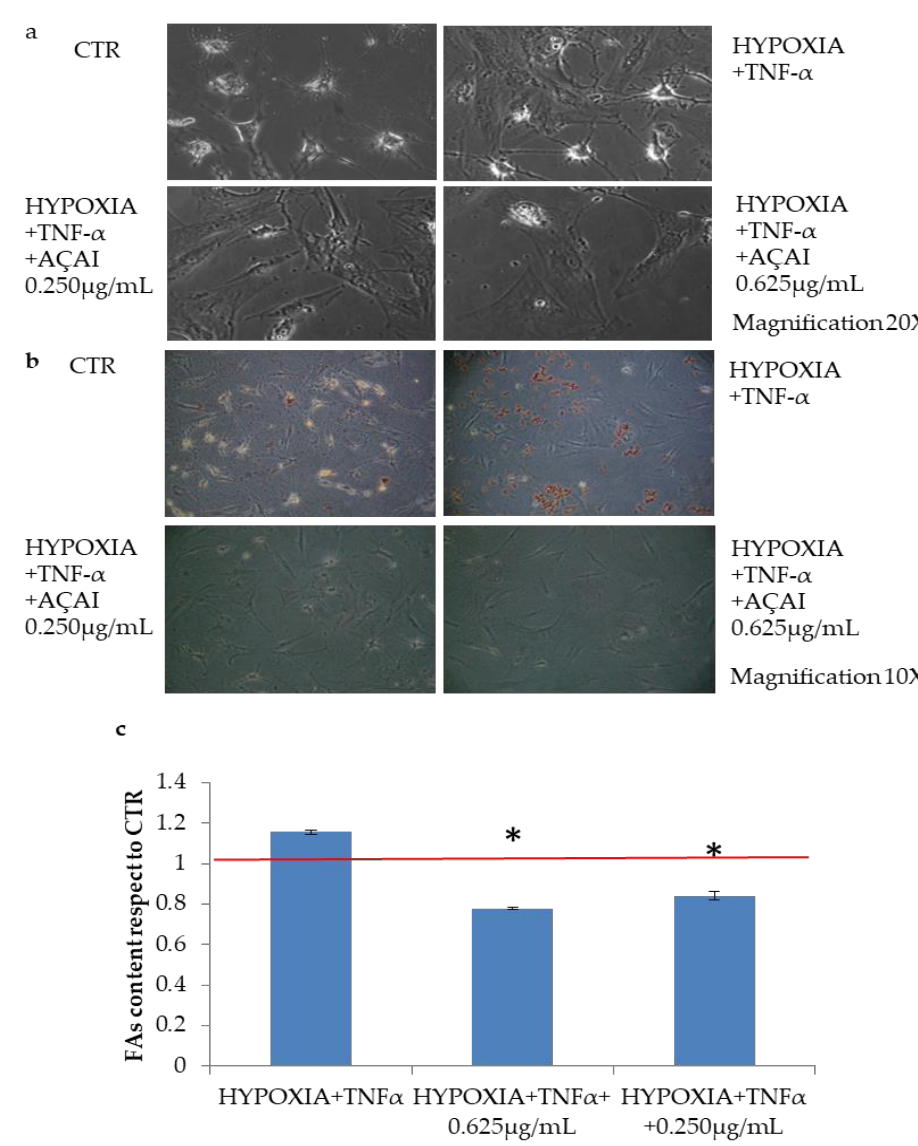
Figure 7. Effects of açai extract on in vitro induced persistent fat accumulation on adipocyte cells. ( a ) Images of adipocyte cells, either untreated and grown in physiological condition (CTR) or grown in hypoxic condition and treated with TNF α before staining, 20 × magnification. ( b ) Oil Red O staining image of fat accumulation in adipocyte cells, 10 × magnification. In physiological condition (CTR) and in the same hypoxic and treatment condition described for point ( a ). ( c ) Spectrophotometric quantification of lipid amount percentage of adipocyte cells treated with açai extract (0.25 and 0.625 µ g/mL) with respect to CTR. Values are expressed as means ± S.D. of independent experiments (n = 3). The red line is relative to CTR that is grown in physiological condition. * indicates p < 0.05; ** indicates p < 0.01.